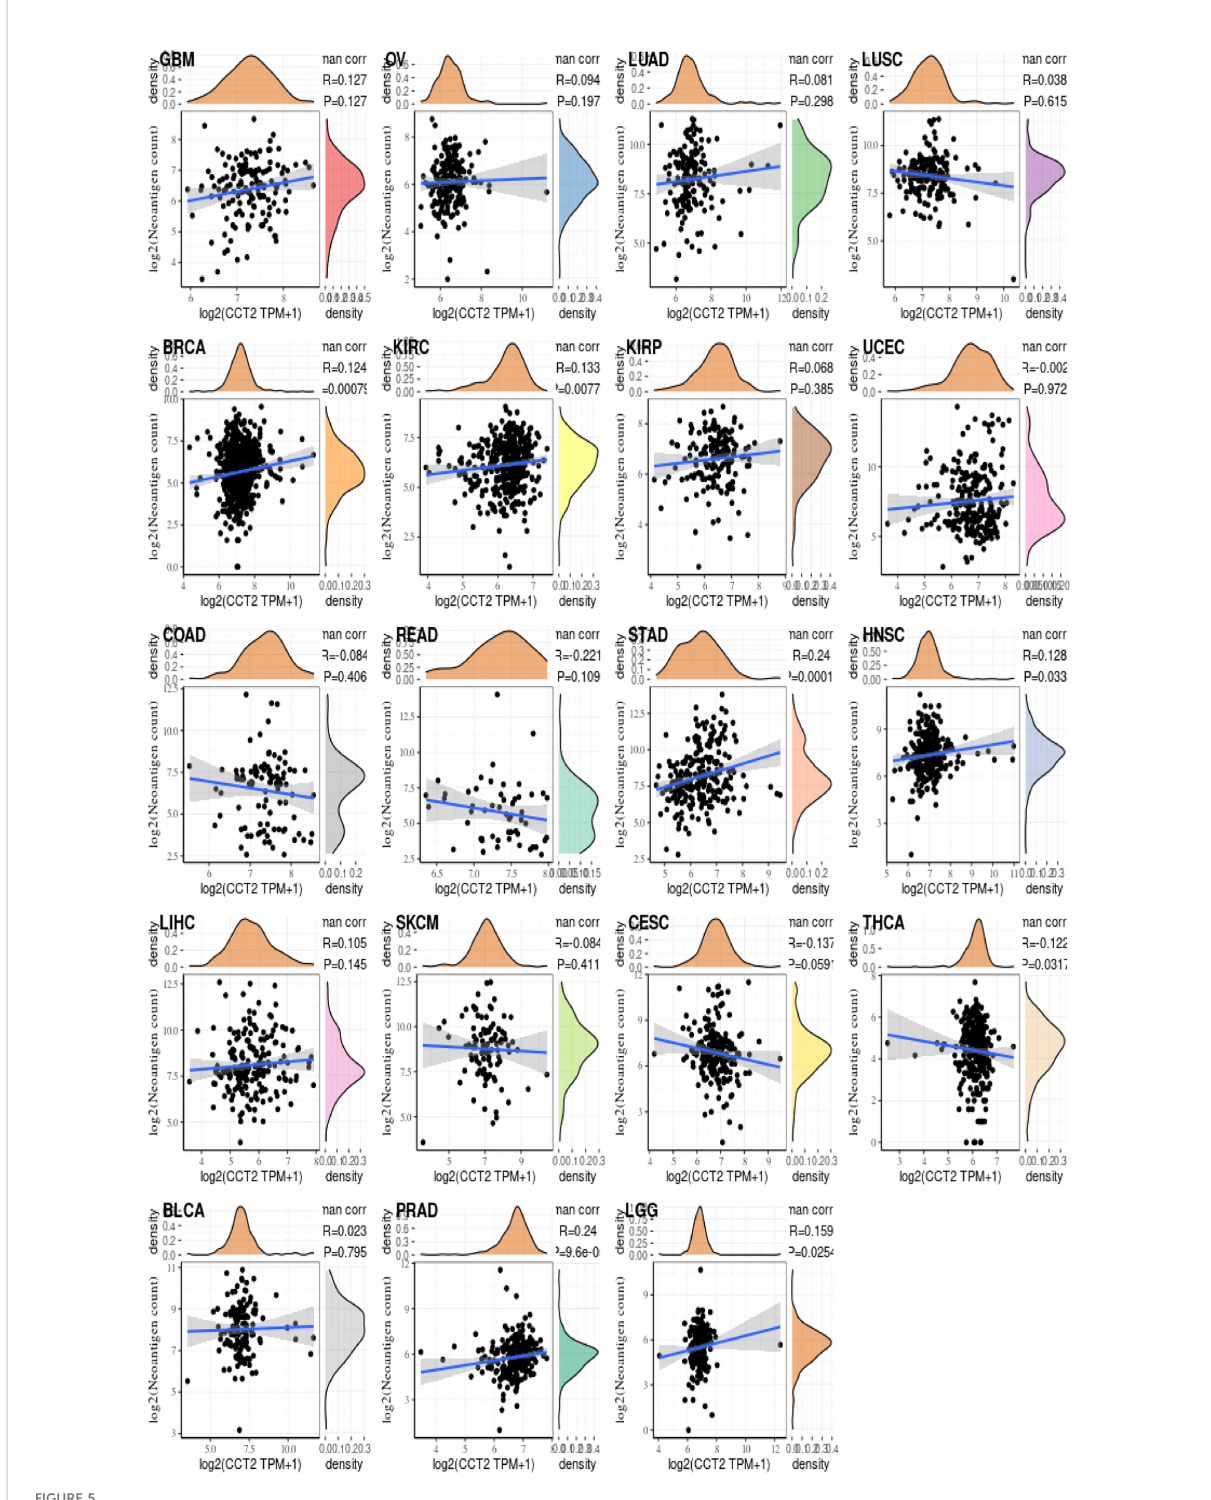
FIGURE 5 CCT2 expression correlates with immune